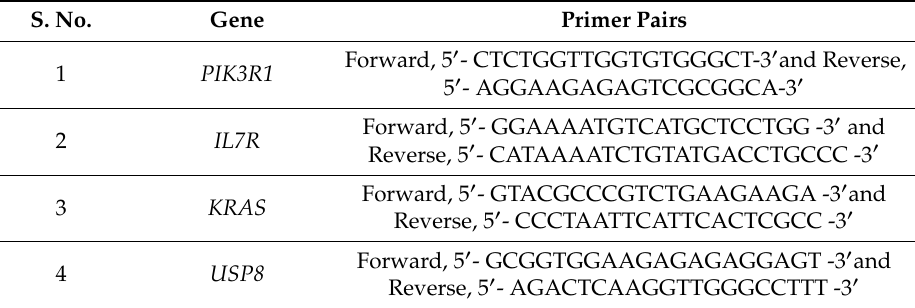
Table 1. Primer pairs used in